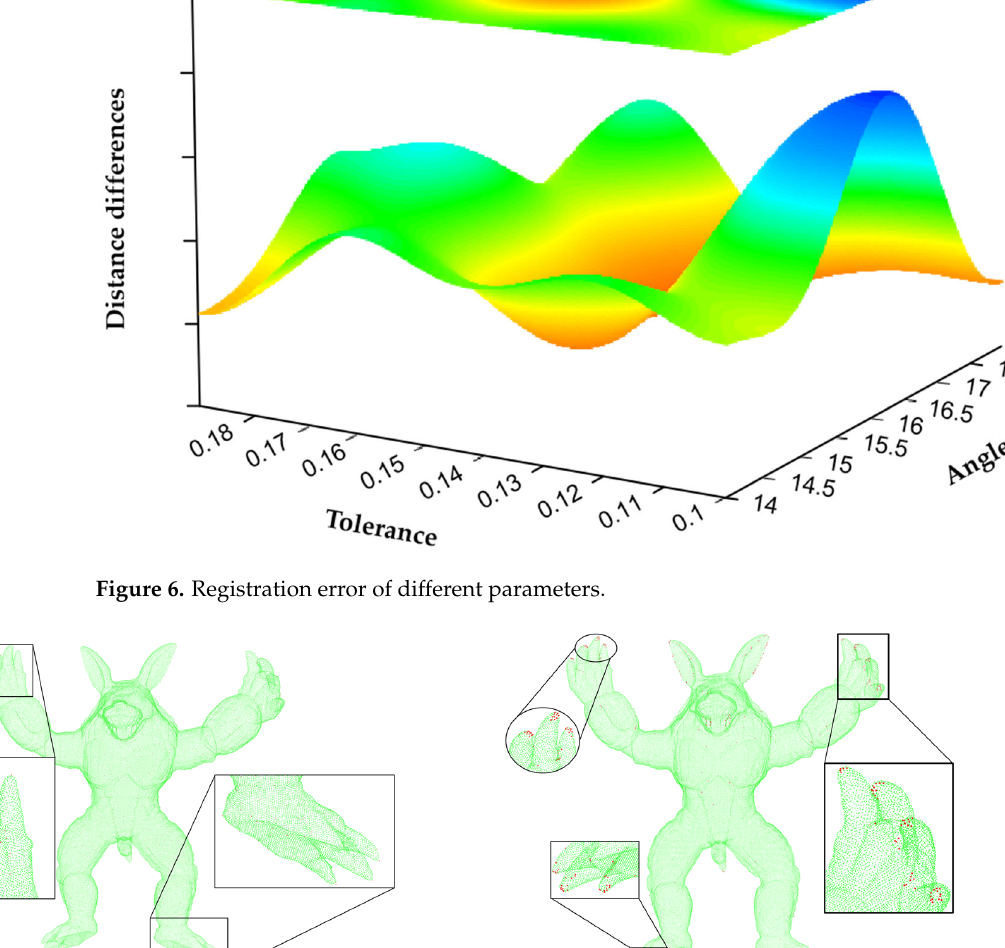
Figure 6. Registration error of different parameters.